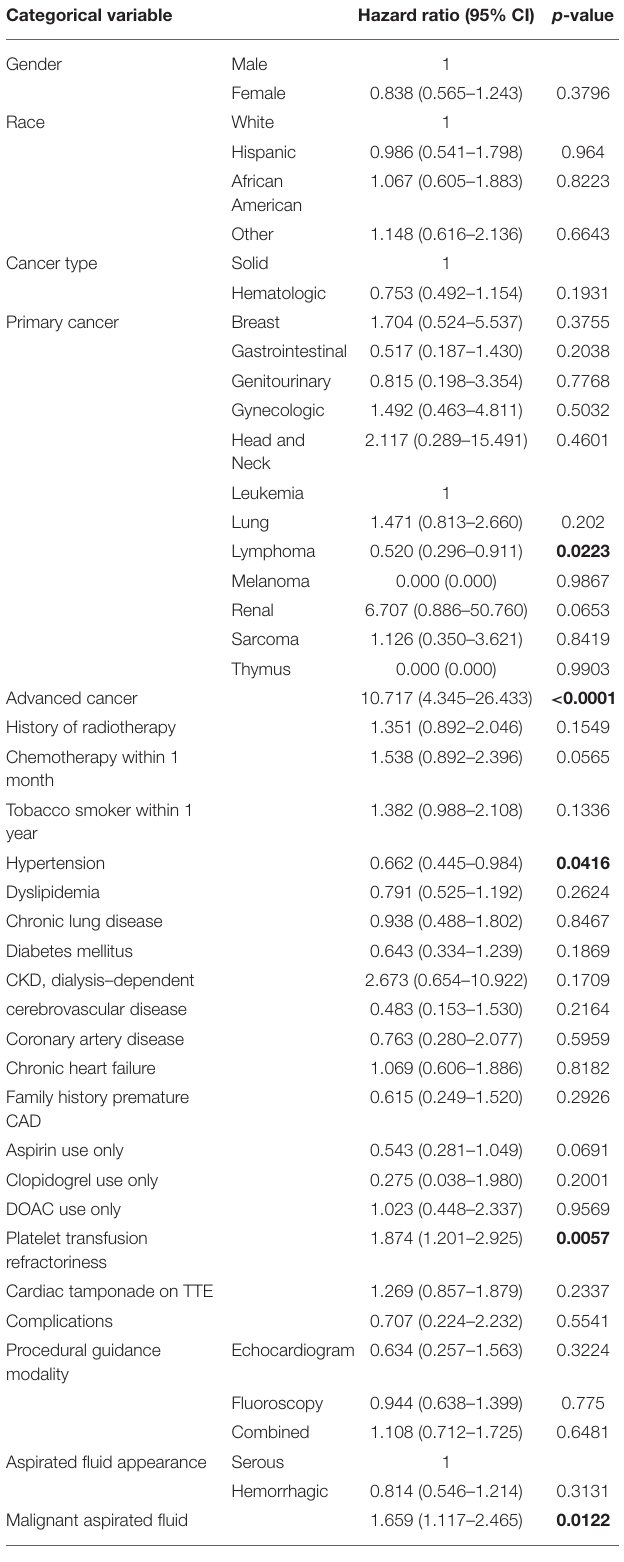
TABLE 2 | Univariate analysis for impact on overall